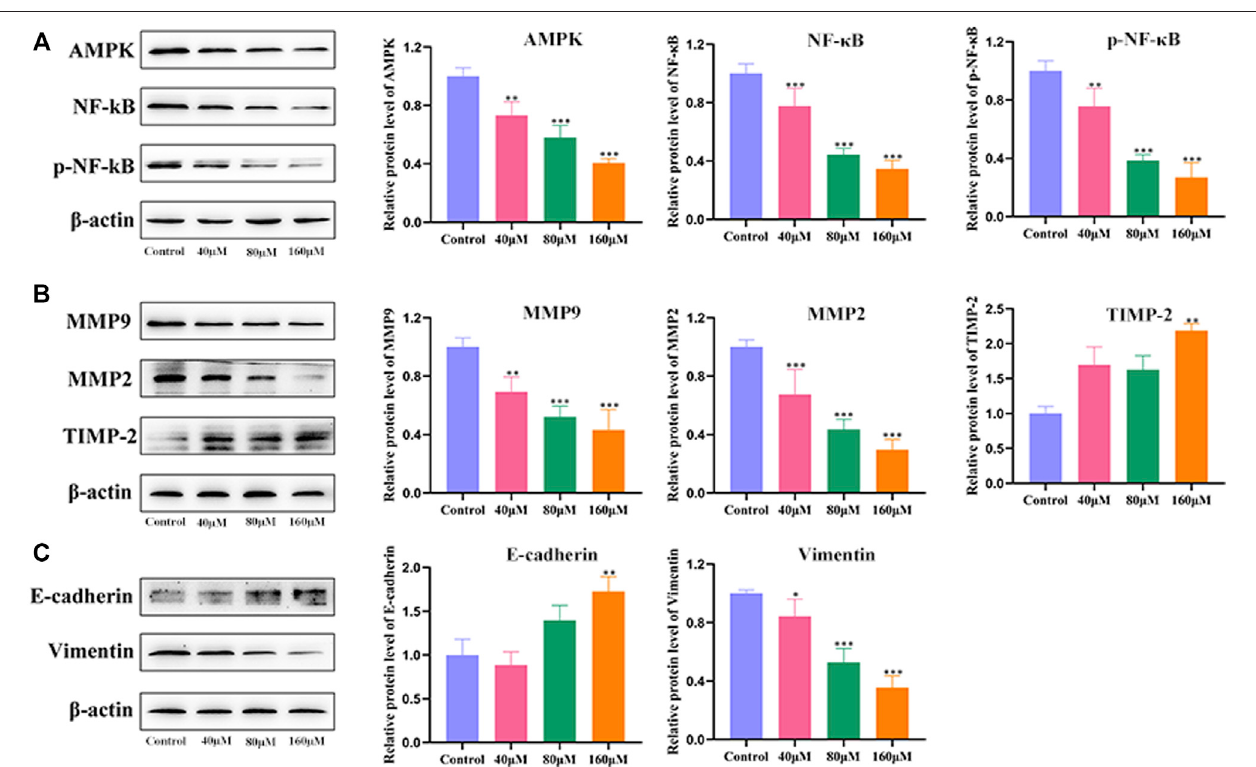
FIGURE 3 | Effect of methyl gallate (MG) on migration, invasion, and related pathway proteins of BEL-7402 cells. (A) The in fl uence of MG on protein expression of AMPK, NF- κ B and p-NF- κ B in BEL-7402 cells was quanti fi ed using western blotting. (B) The effect ofMG on the expression of MMP9, MMP2 and TIMP-2 in BEL-7402 cellsandthecorrespondingstatisticalanalysisofproteinlevels. (C) EffectofMGontheexpressionofE-cadherinandVimentininBEL-7402cellsandstatisticalanalysisof proteinlevels.Datafromatleastthreeindependentexperimentsarepresentedasthemean±standarddeviation.* p < 0.05,** p < 0.01and*** p <